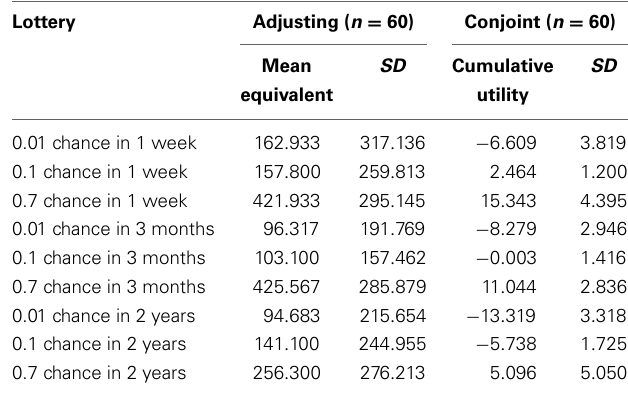
Table 4 | Discounting equivalents (cumulative utilities) calculated for each lottery with adjusting (conjoint) method within Study 2.